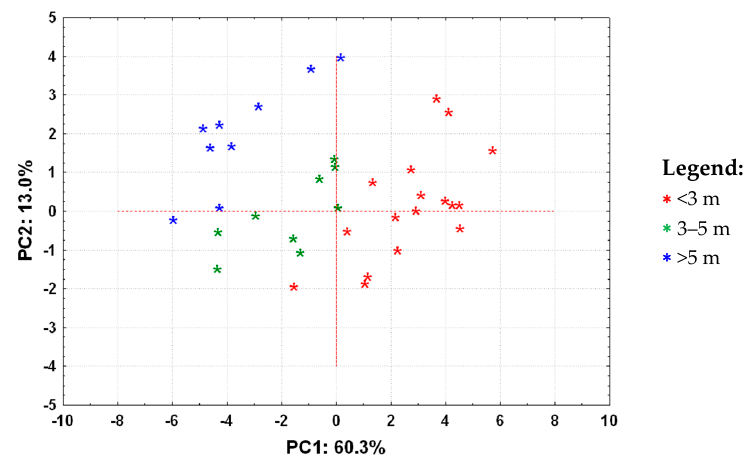
Figure 5. PCA score plot for PC1 vs. PC2. Sampling locations divided into three groups according to the depth [10].